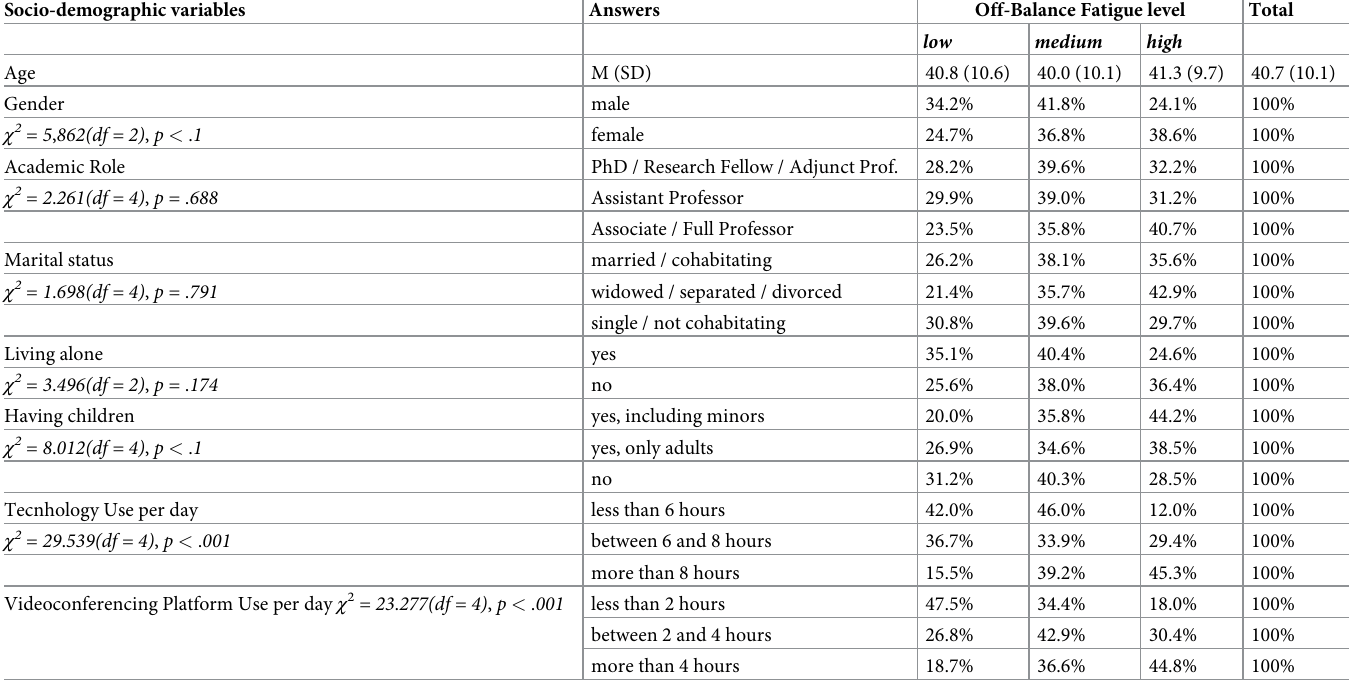
Table 6. Results of contingency table–Off balance fatigue subscale. Socio-demographic